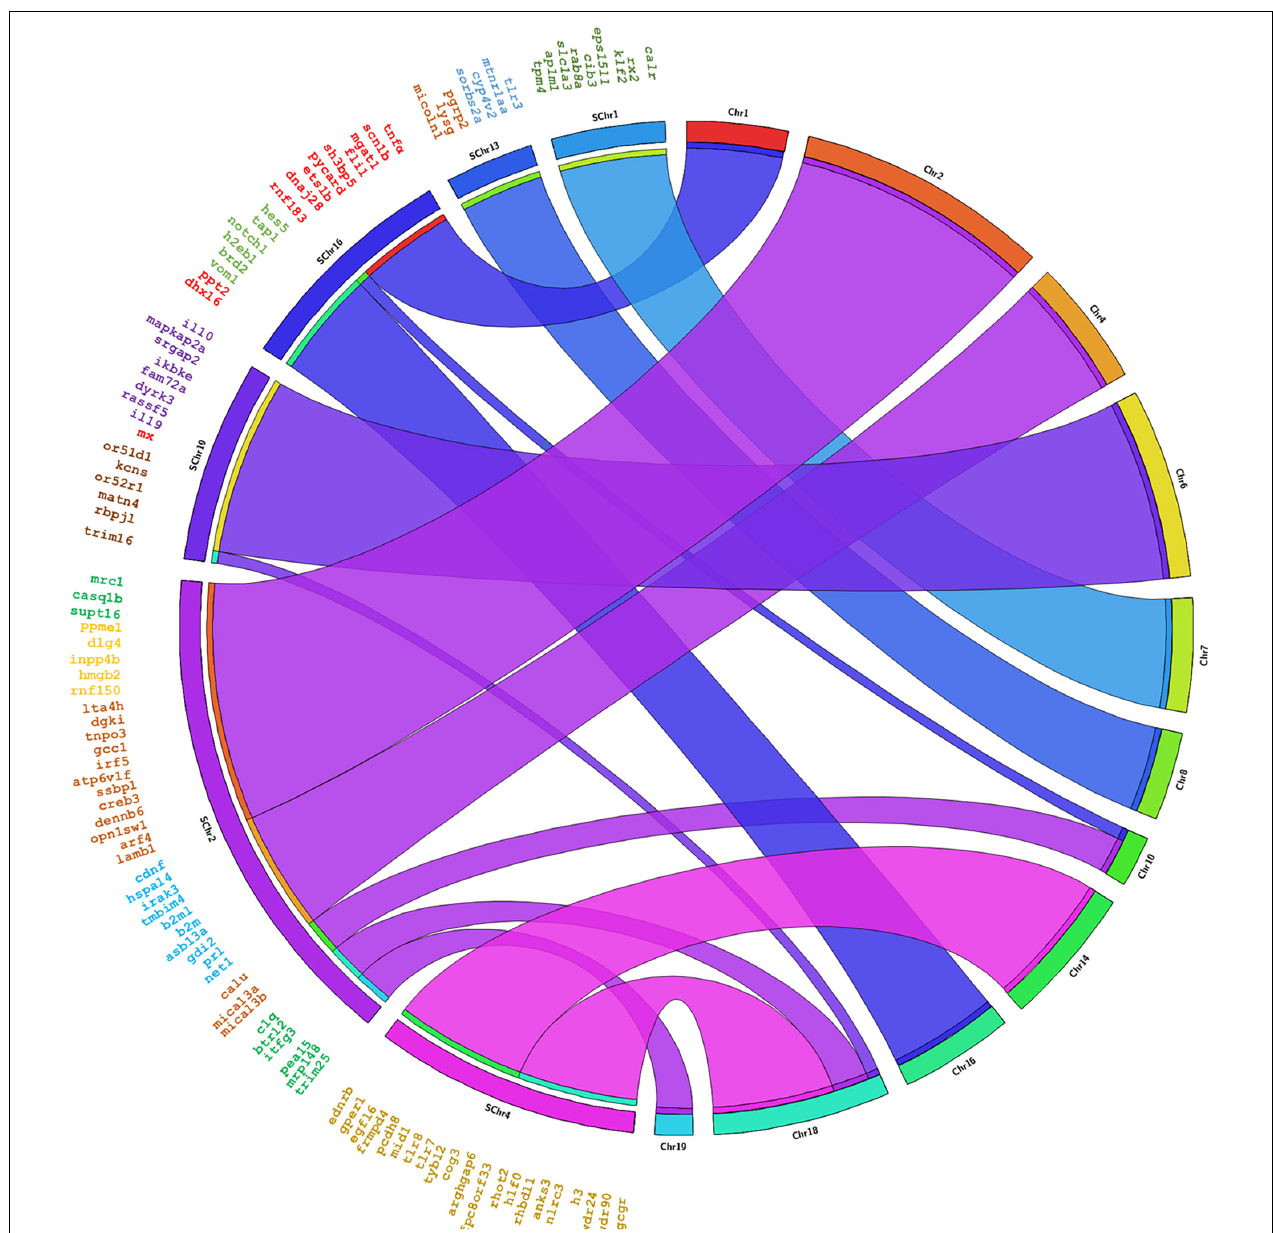
FIGURE 4 | Circos analysis in the species S. maximus. On the left side the distribution of the BAC clones of Senegalese sole distributed in chromosomes can be observed. Each BAC clone is represented in a different color. The genes found by annotation are indicated within each BAC clone and their corresponding localization in the S. maximus chromosomes are denoted by crossing lines. The BAC clones analyzed are given in Table 1